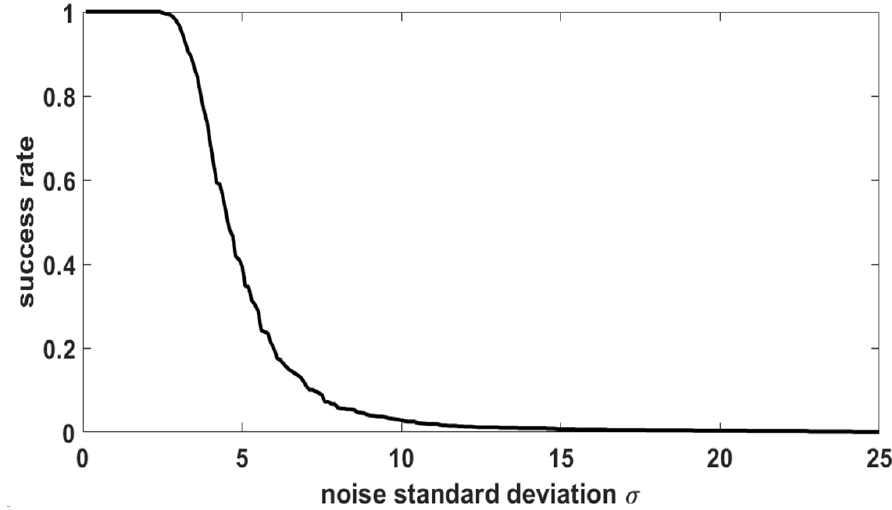
Figure 6. Success rate according to noise standard deviation ( α 0 =